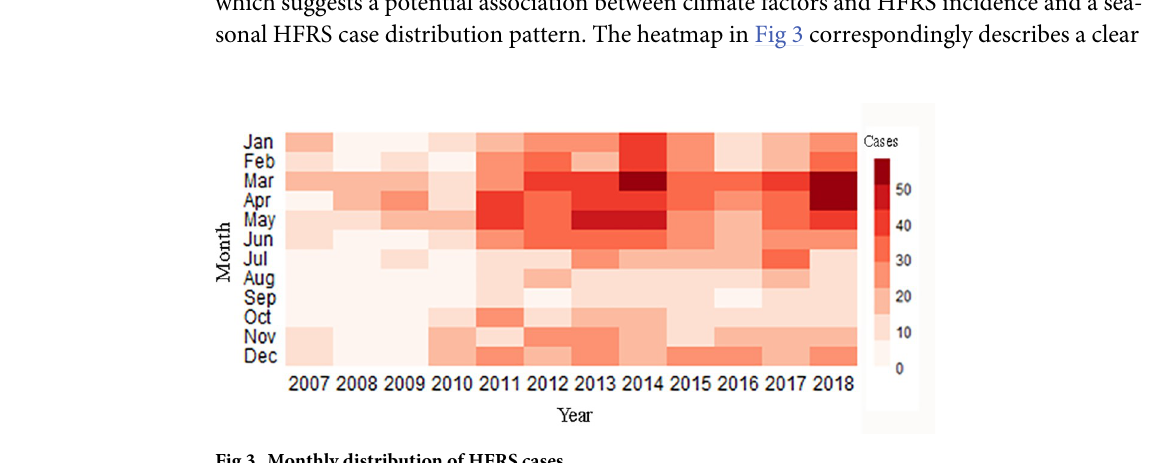
± 54.00 mm. The temporal trends of HFRS cases and meteorological factors are shown in Fig 2, which suggests a potential association between climate factors and HFRS incidence and a sea- sonal HFRS case distribution pattern. The heatmap in Fig 3 correspondingly describes a clear